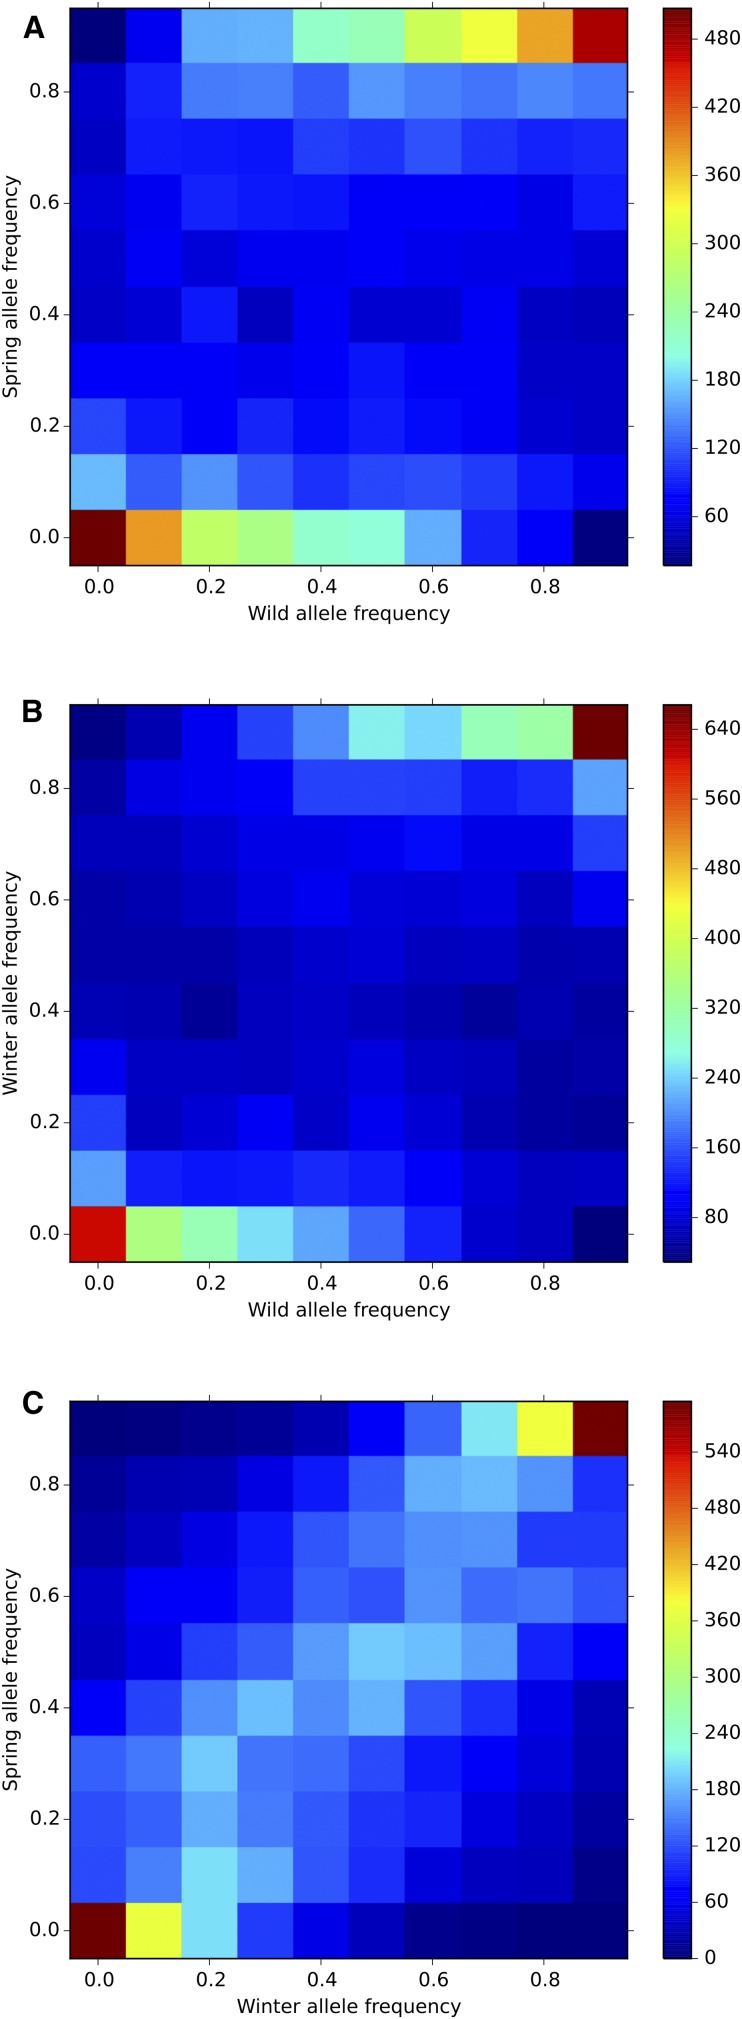
Joint allele frequency densities between wild and spring peas (A), wild/landrace and winter peas (B), and spring and winter peas (C). The color scale shows the minor allele frequency (MAF) counts (number of SNPs in that class of frequency, 10 equally spaced bins having been used to discretize the allele frequencies).